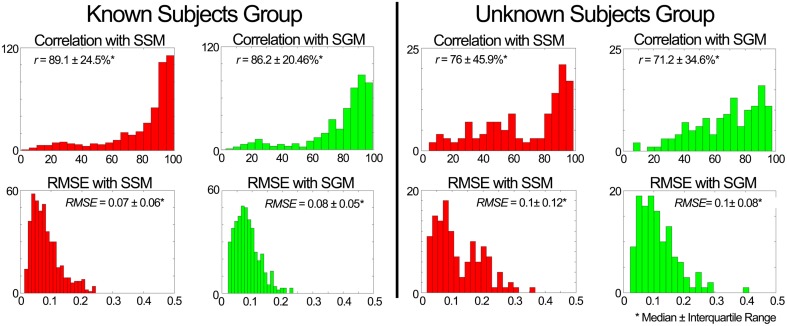
Performance assessment of the weight predictor block in scenario 1. The plots depict histograms of the average (median ± interquartile range) correlation coefficient (r) and root mean square error (RMSE) between the estimated and experimental weightings.